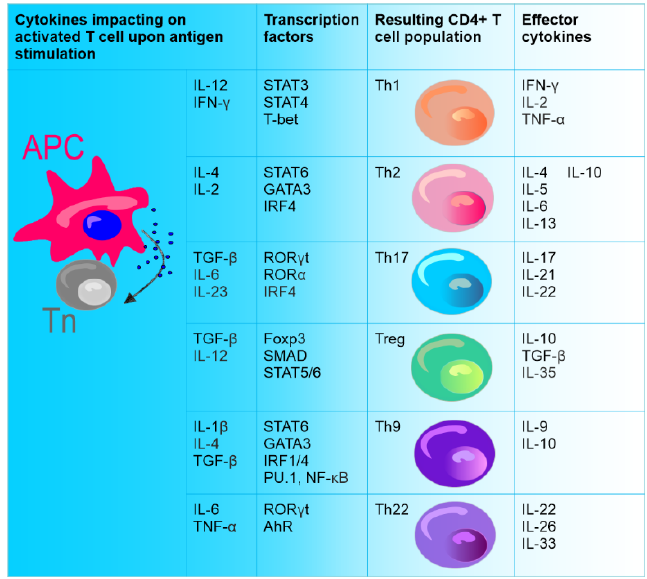
Figure 1. Differentiation of naïve CD4+ T cells (Tn). Naive CD4+ T cells (stem cell-like cells), under